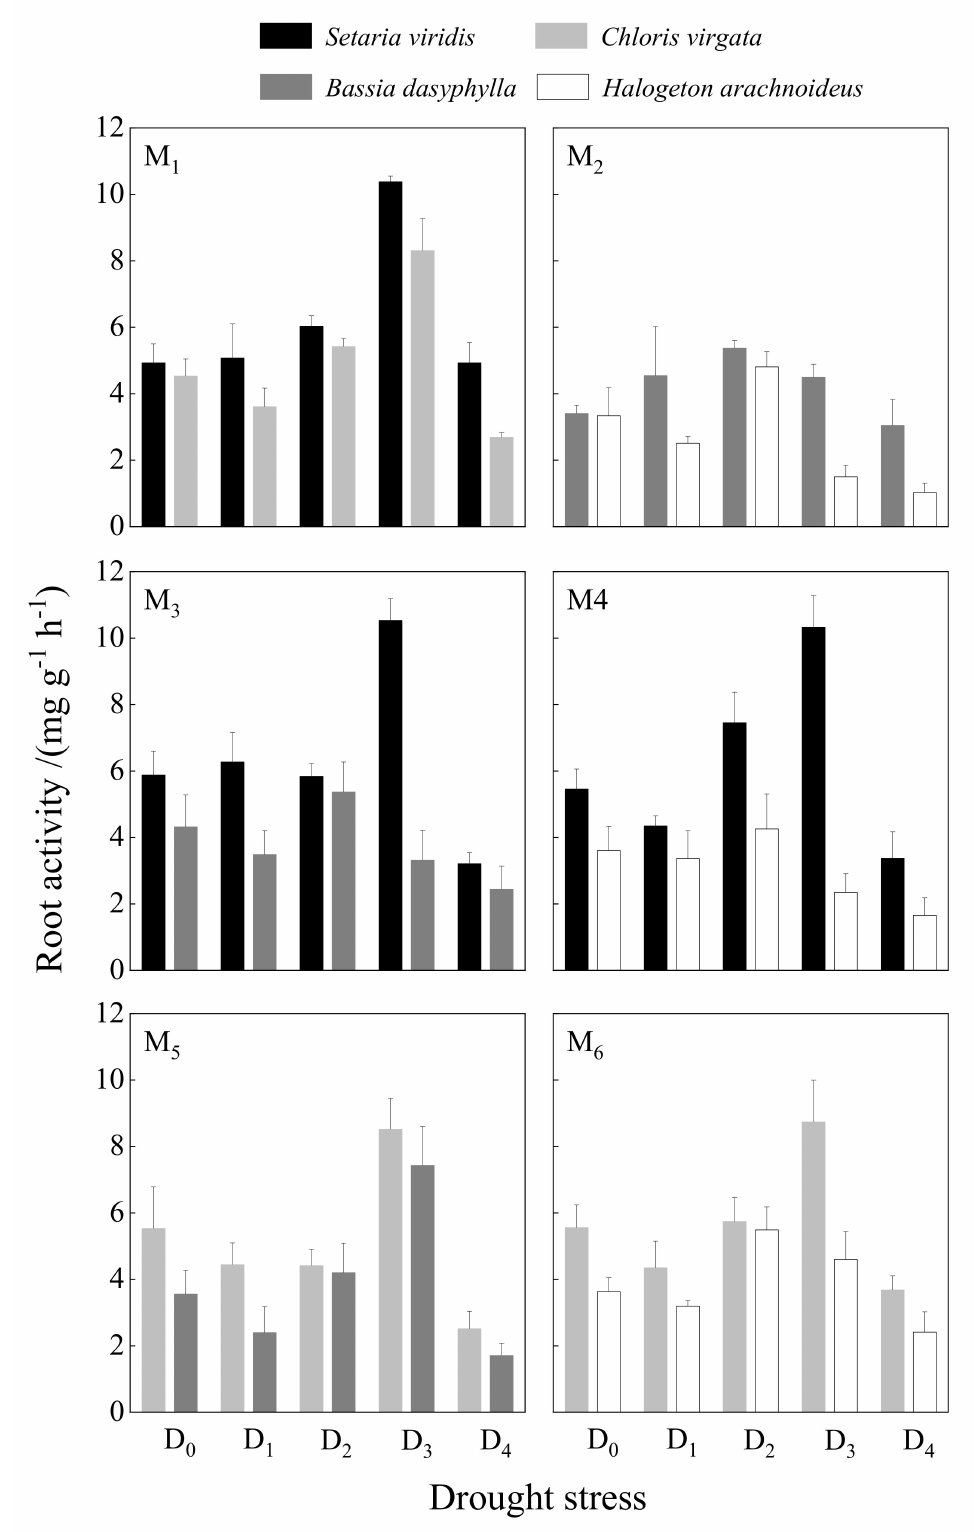
Figure 3. Response of root activity of four annual desert plants to the interactive treatment of drought and mixed sowing (D0–D4 represents five drought stress gradients and D0–D4 represents PEG-6000 solution with different concentrations simulating different drought stress gradients, respectively: control 0% (D0), mild drought 2% (D1), moderate drought 5% (D2), moderate and high drought 10% (D3), and severe drought 15%